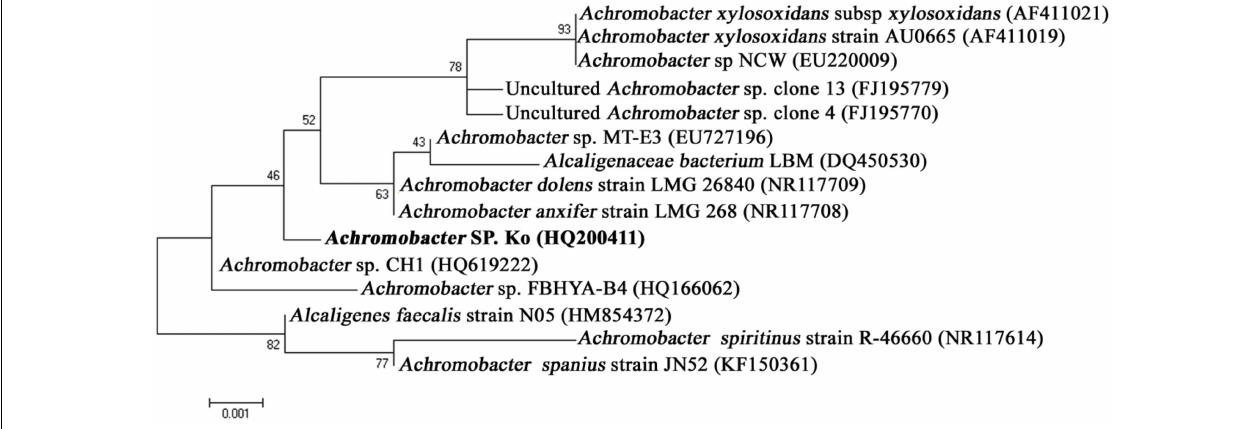
Frontiers in Microbiology |